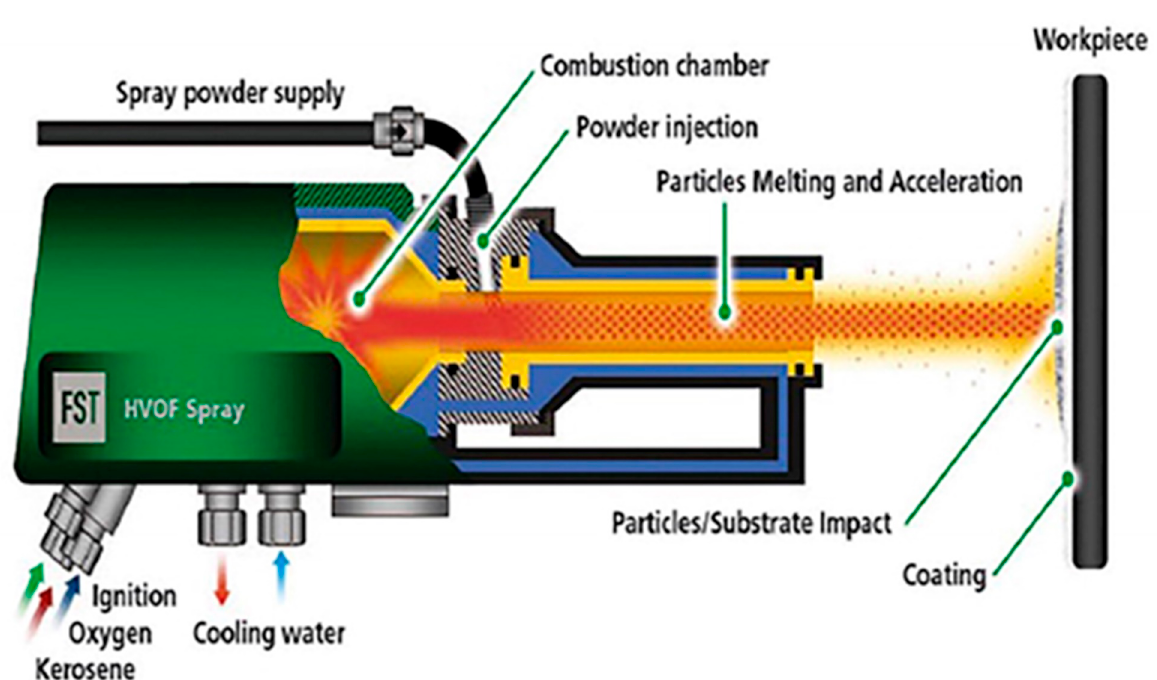
Figure 3. HVOF working principle. Reprinted with permission from [45]. 2021, G. Padmavathi.